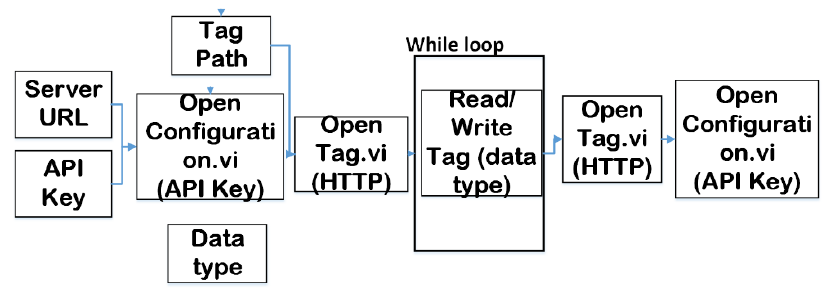
Figure 7. SystemLink Cloud API Connection.